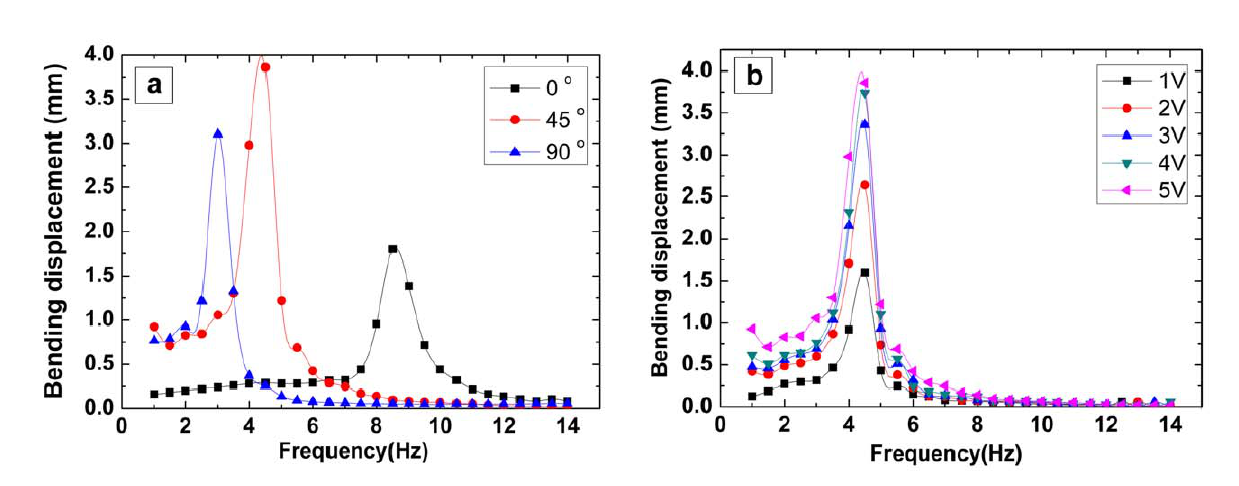
Figure 3. Actuator performance of piezo-paper bending actuator depending on a) orientation and b) applied voltage (Thickness: 22 µm, Young’s modulus: 8.9 GPa